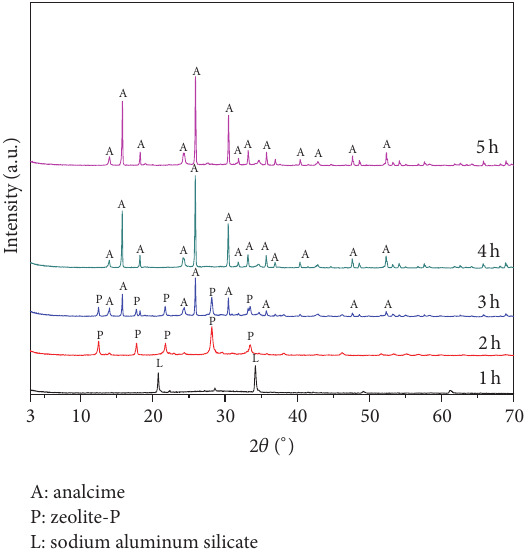
Figure 7: XRD patterns of the products obtained at different crystallization time.